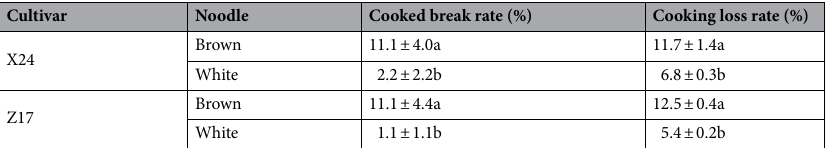
Table 3. Cooking properties of brown and white rice noodles processed from two rice cultivars, Xiangzaoxian 24 (X24) and Zhongjiazao 17 (Z17). Data are mean ± SE ( n = 3). Within a column, data sharing the same lowercase letters are not significantly different at the 0.05 probability level.